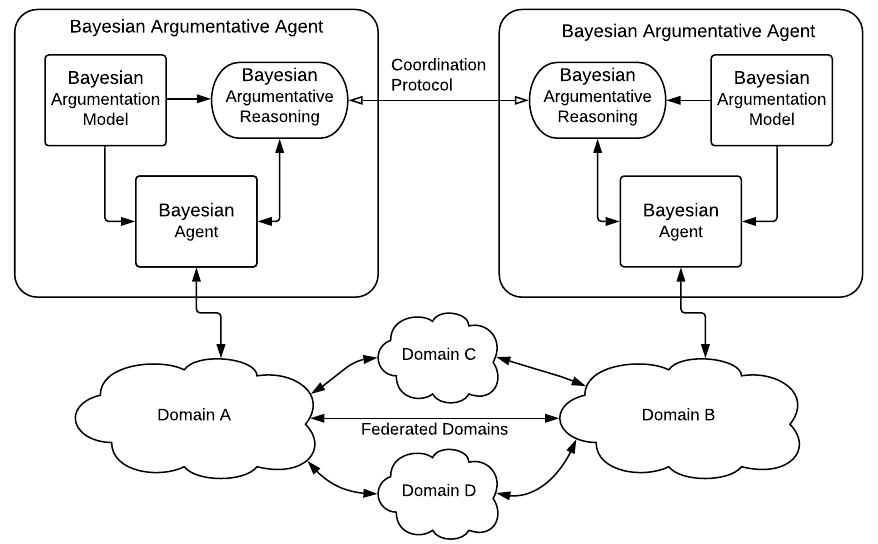
Figure 1. Overview of Bayesian Argumentative agents in federated